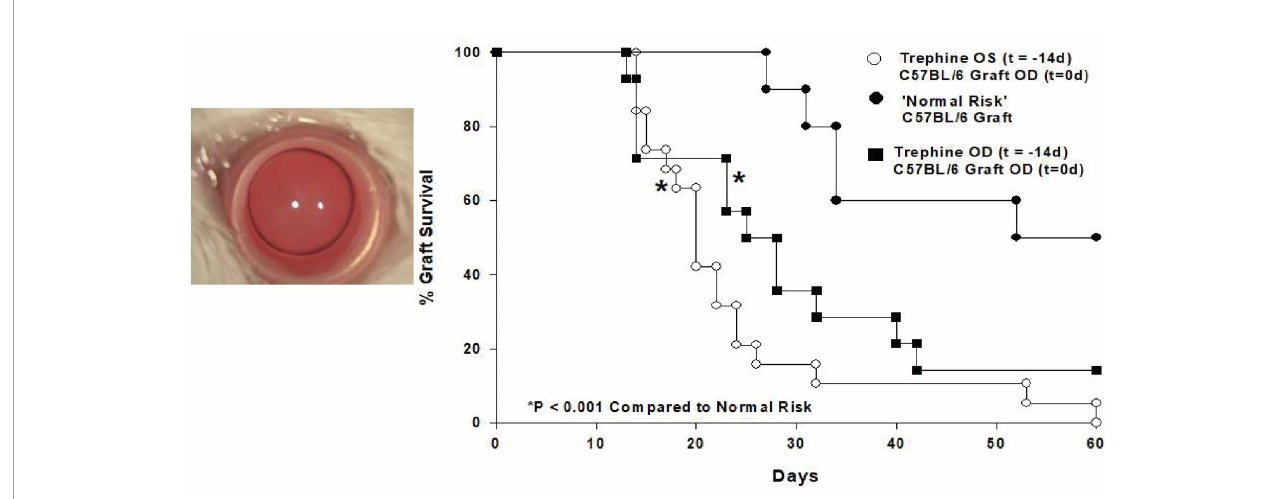
FIGURE 3 | Shallow circular incisions of the cornea in one eye abolishes ACAID in both eyes. 360° corneal incisions were placed in left (OS) eyes of BALB/c mice 14 days prior to application of C57BL/6 corneal allografts to the right (OD) eyes. (Modi fi ed from Paunicka et al.